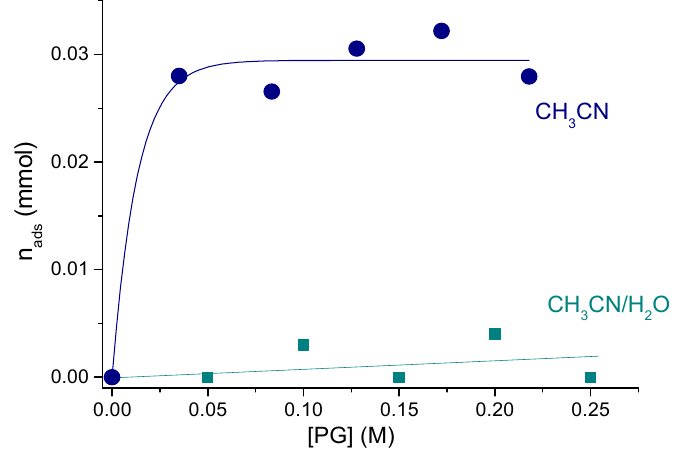
Figure 4. Propylene glycol (PG) adsorption on UiO-66 from CH 3 CN and CH 3 CN/H 2 O (7/3